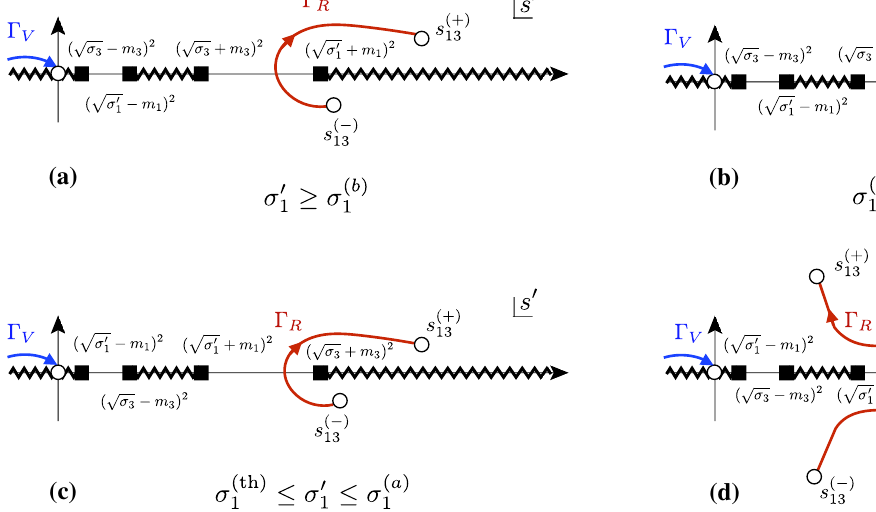
( a ) ≥ σ ( b ) are: a σ (cid:6) , b σ 1 1 1 1